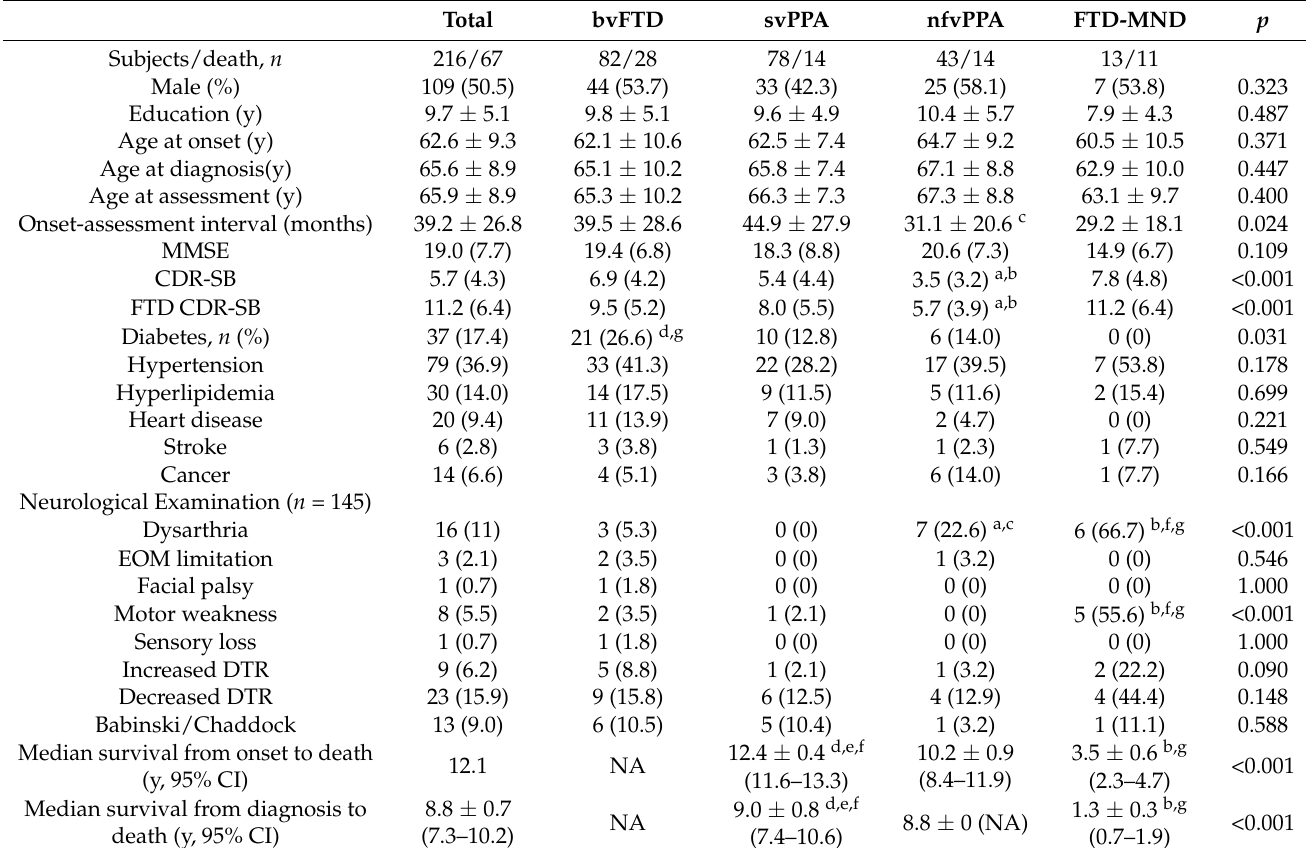
Table 1. Demographic characteristics and median survival of the study